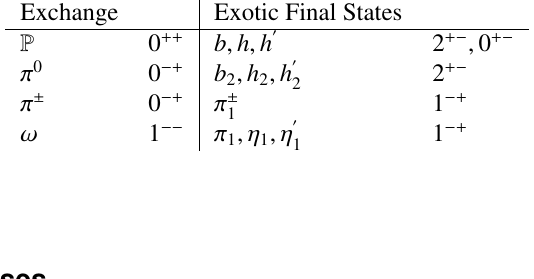
Table 1: A set of possible exchanges in γ p interactions and their associated exotic final states.